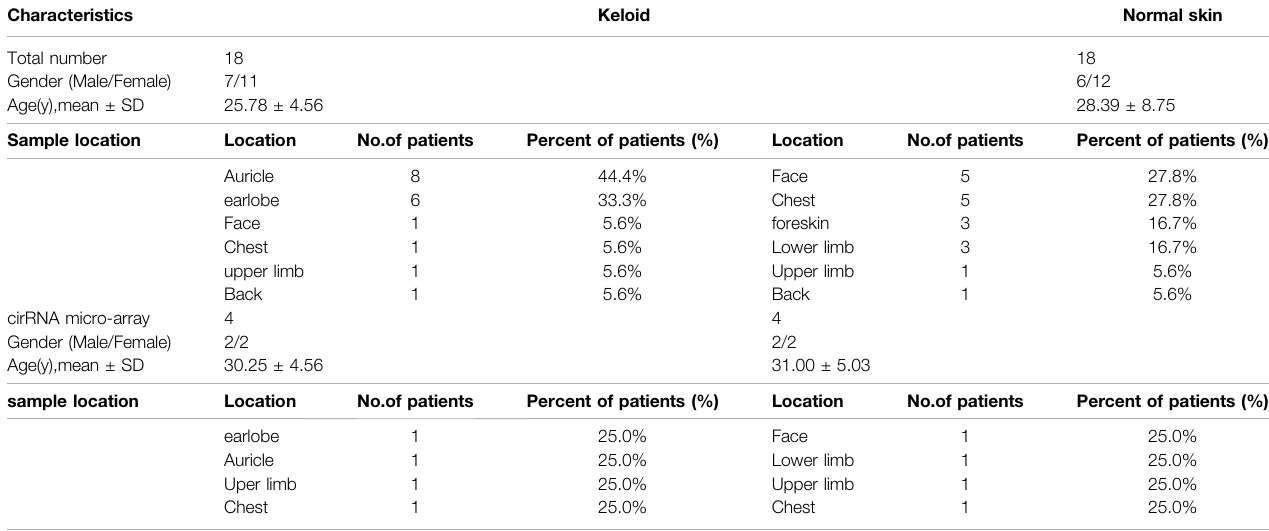
TABLE 3 | Clinical information of included